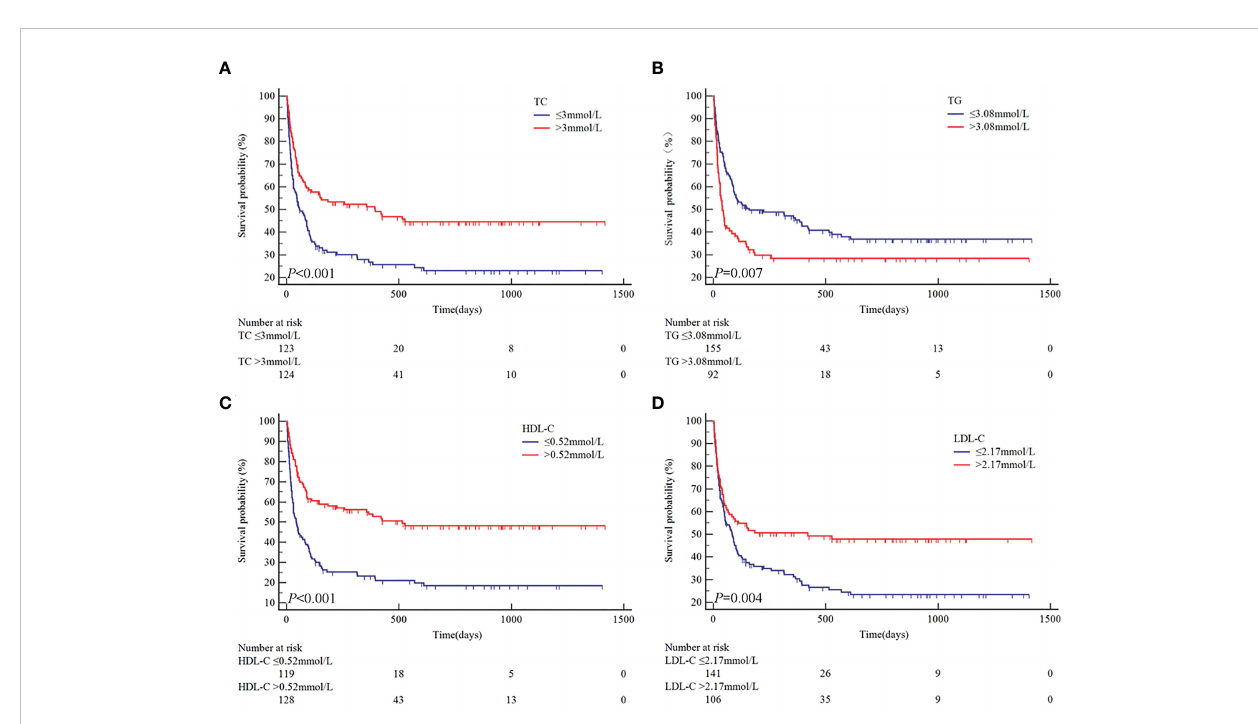
FIGURE 3 Univariate analysis of overall survival according to TC (A) , TG (B) , HDL-c (C) , and LDL-c (D)